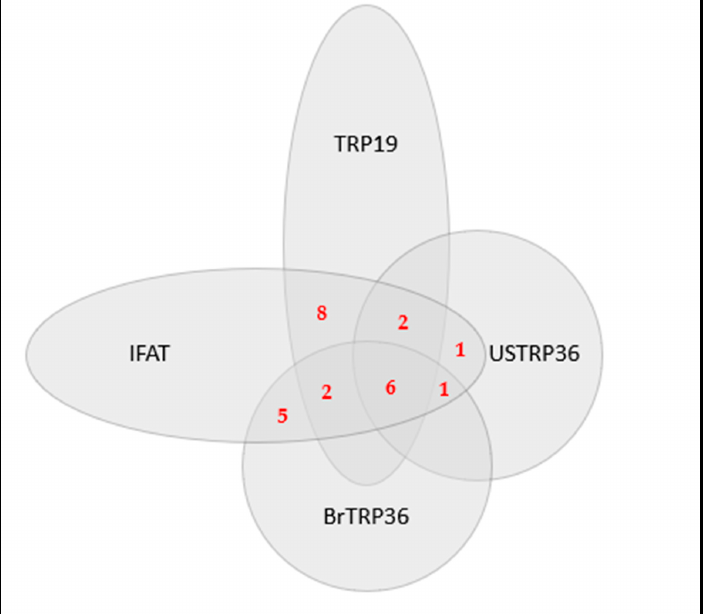
Figure 1. Venn diagram showing combinations of Ehrlichia canis antibodies detected in feline serum samples subjected to the indirect fluorescence antibody test (IFAT) with Ehrlichia canis antigens, and enzyme-linked immunosorbent assay (ELISA) with synthetic peptides TRP19, BrTRP36 and USTRP36.